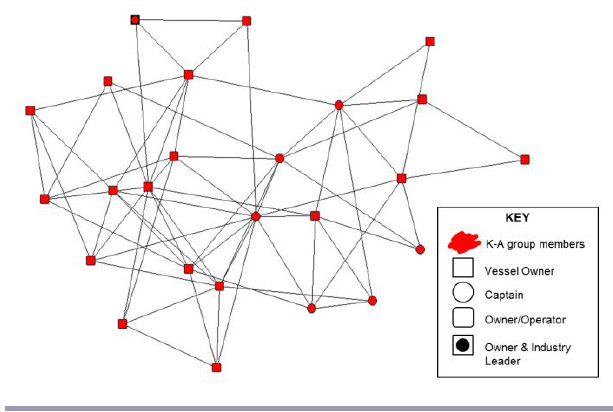
Fig. 5 . Network configuration of ties within the Korean- American (K-A) community. Nodes (representing actors) with the smallest path lengths to each other are placed closest together by an algorithm that uses iterative fitting.